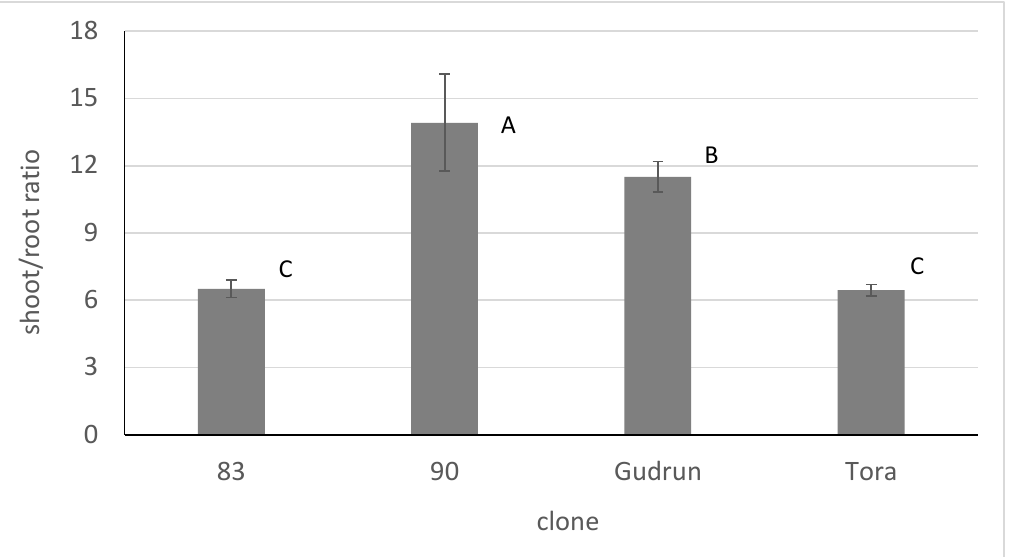
Figure 5. The average ratio between shoot and root biomass for cuttings of various clones at four-week harvest in 2010. The bars represent SE ( n = 30). The values with distinct letters differ from each other significantly (REGW test). Forests 2017 , 8 , x FOR PEER REVIEW